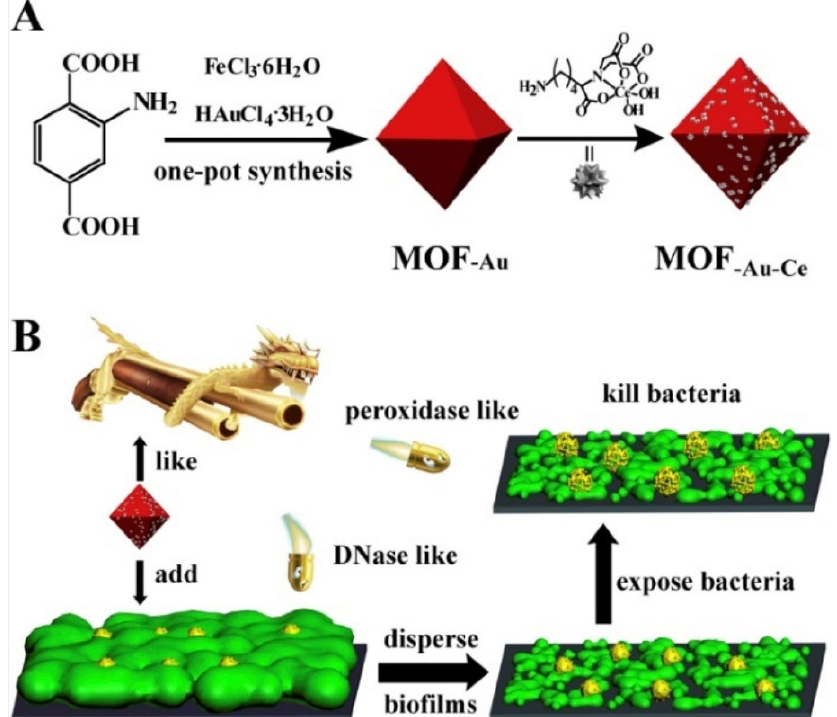
Figure 25. ( A ) Reaction scheme showing the synthesis of MOF Au ‐ Ce , and the post ‐ synthetic treatment of attaching Ce to MOF surface. ( B ) Antimicrobial activity of MOF Au ‐ Ce is illustrated showing that the MOFs can have dual enzyme mimetic activity, peroxidase like, and DNase like. Reproduced with permission from [204] .